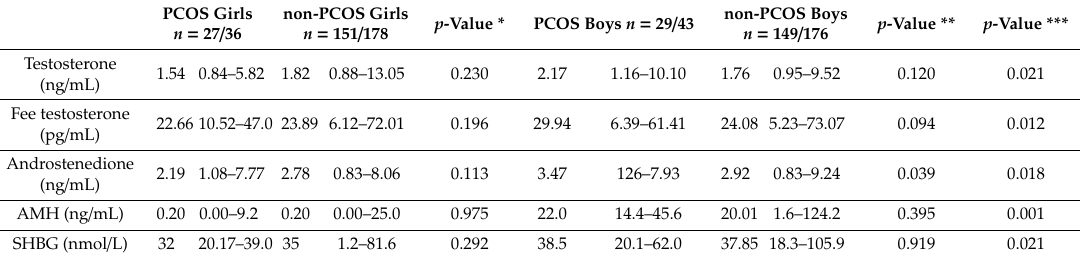
Table 3. Comparison of androgens and AMH in PCOS girls, non-PCOS girls, PCOS boys, and non-PCOS